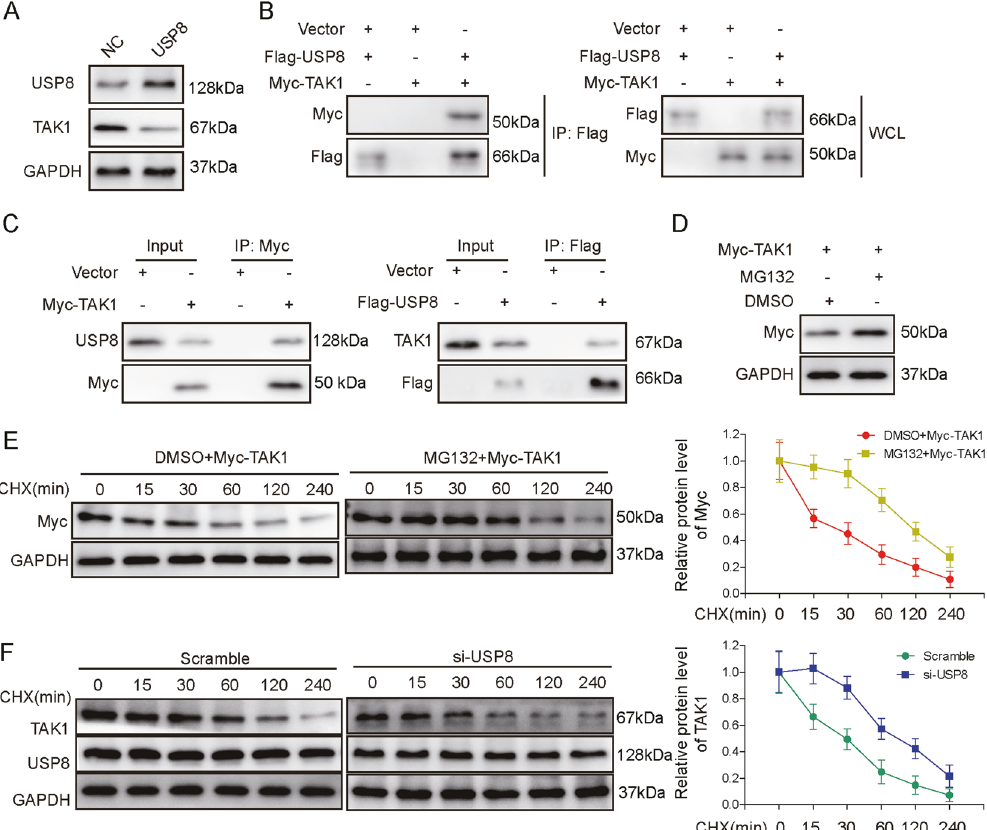
Fig. 6 USP8 promoted ubiquitination and degradation of TAK1. A The protein levels of USP8 and TAK1 were examined by western blot in KCs overexpressing control (NC) or USP8. B The interaction between USP8 and TAK1 was examined by Co-IP in HEK293T cells co-transfected with Myc-tagged TAK1 and Flag-tagged USP8 (left and middle panels). C The interaction between endogenous USP8 and Myc-TAK1, and that between endogenous TAK1 and Flag-USP8 was examined by Co-IP in HEK293T cells. D KCs were transfected with Myc-TAK1 and treated with or without MG132. The level of TAK1 was examined by western blot. E KCs cells from D were treated with cycloheximide (CHX) for indicated time periods. The expression of TAK1 was examined by western blot. F si-NC- or si-USP8-transfected KCs were treated with CHX for indicated time periods. The protein levels of TAK1 and USP8 were examined by western